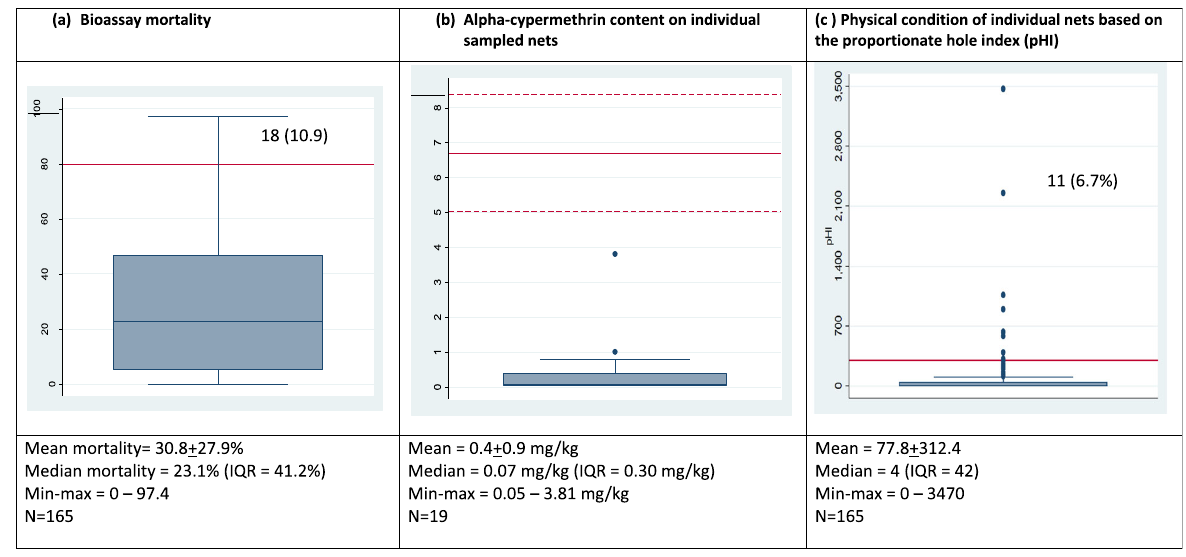
Fig. 3 Boxplot of Interceptor LLIN showing a median mortality, inter-quartile range (0.25 – 0.75), and max-min range. Full red line is the 80% mortality threshold. b Target dose of alpha-cypermethrin (full red line) and tolerance limits (± 25% of target dose, dashed lines ( b ), and ( c ) mean pHI threshold for replacement of nets (full red line. Nos (%) indicate the number of data points (percent)